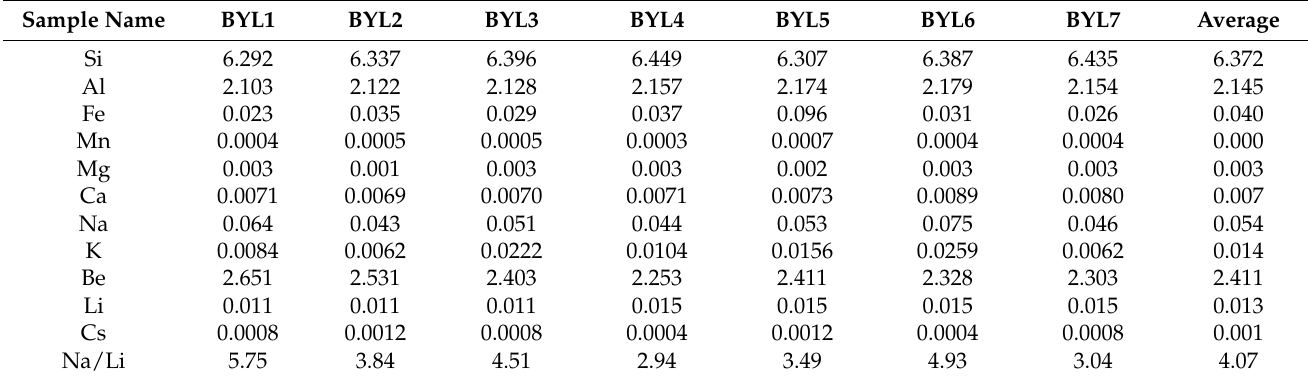
Table 2. Chemical compositions (apfu) based on 18 oxygen atoms in the Ebrahim-Attar beryl.